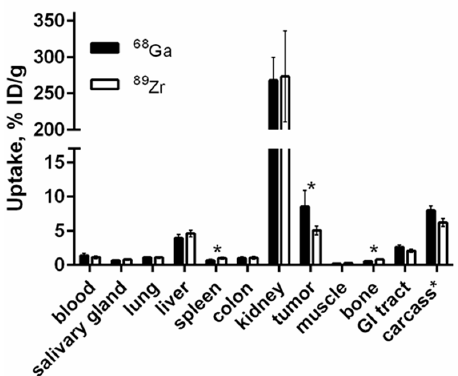
Figure 7. Biodistribution of [ 68 Ga]Ga-DFO-ZEGFR:2377 and [ 89 Zr]Zr-DFO-ZEGFR:2377 conjugates in BALB/C nu/nu mice bearing EGFR-expressing A431 xenografts 3 h after injection. The data were presented as the average (n = 7) and SD. Error bars might not be seen because they are smaller than the symbols. Asterisk (*) marks significant ( p < 0.05) difference.